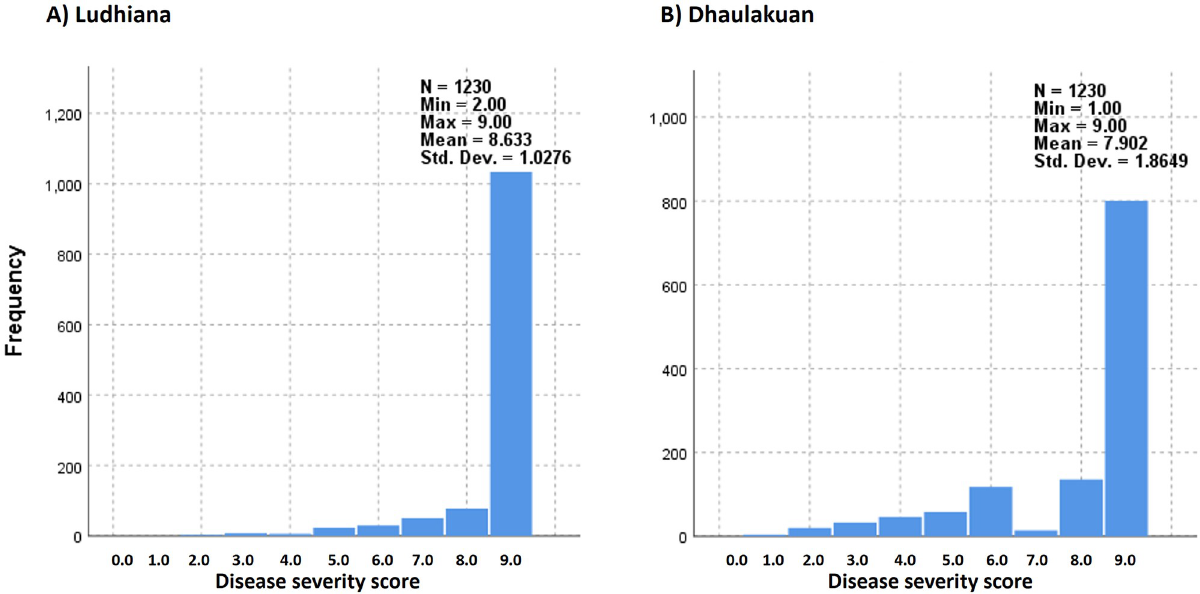
Fig 3. Classification of chickpea germplasm based on their response to ascochyta blight disease. In this graphical representation 1,230 accessions are included from screening experiment of three seasons (2014–15 to 2016–17) at Ludhiana (A) and Dhaulakuan (B) locations.